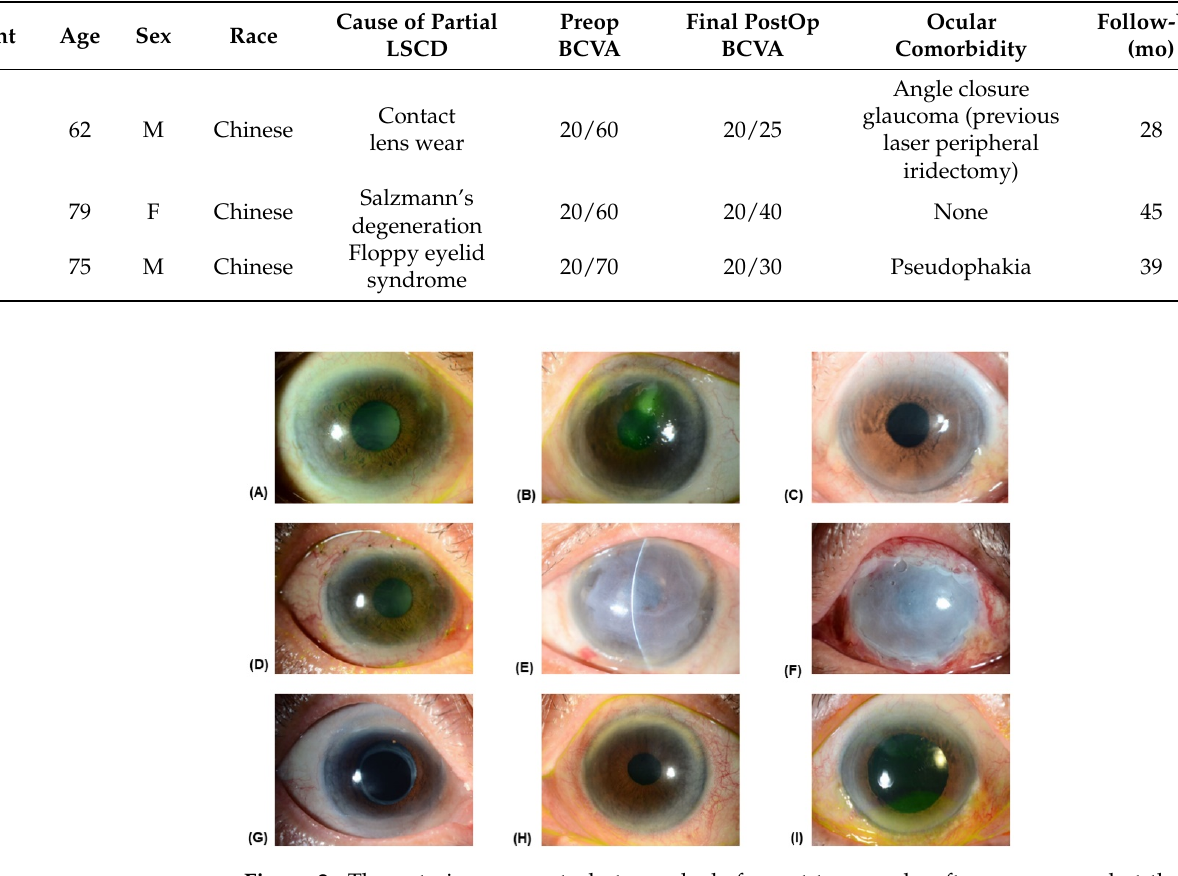
Figure 2. The anterior segment photographs before, at two weeks after surgery, and at the last follow-up visit. ( A – C ) Preoperative photographs of patients 1, 2, and 3, respectively, demonstrate partial LSCD involving visual axis. ( D – F ) At two weeks postoperatively, the conjunctival epithelial tissue at the site of partial LSCD migrated onto the outer AM. ( G – I ) All eyes maintained clear corneal epithelium at the last follow-up visit (In patient 3, a focal area of recurrence of the superficial fibrovascular pannus was observed at the superonasal area but did not affect the visual axis.).